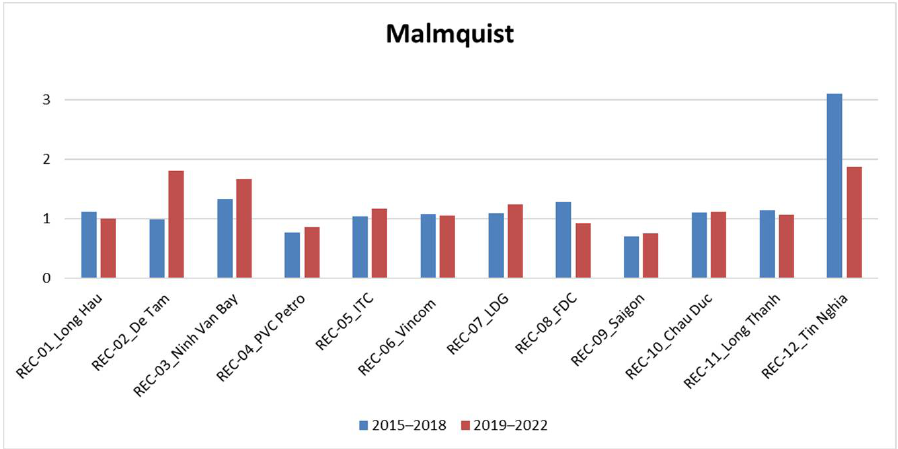
Figure 10. The comparison of total factor productivity change.